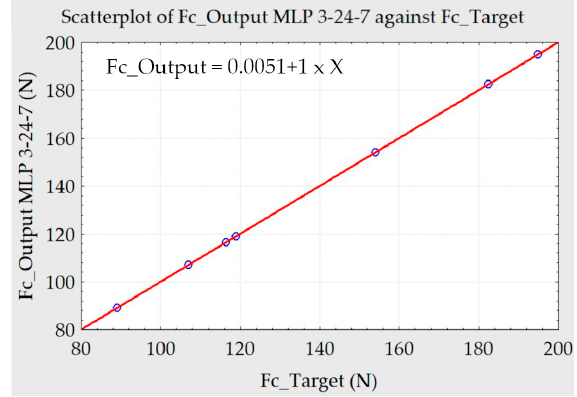
Figure 10. Scatterplot of Fc_Target x Fc_Output ANN.